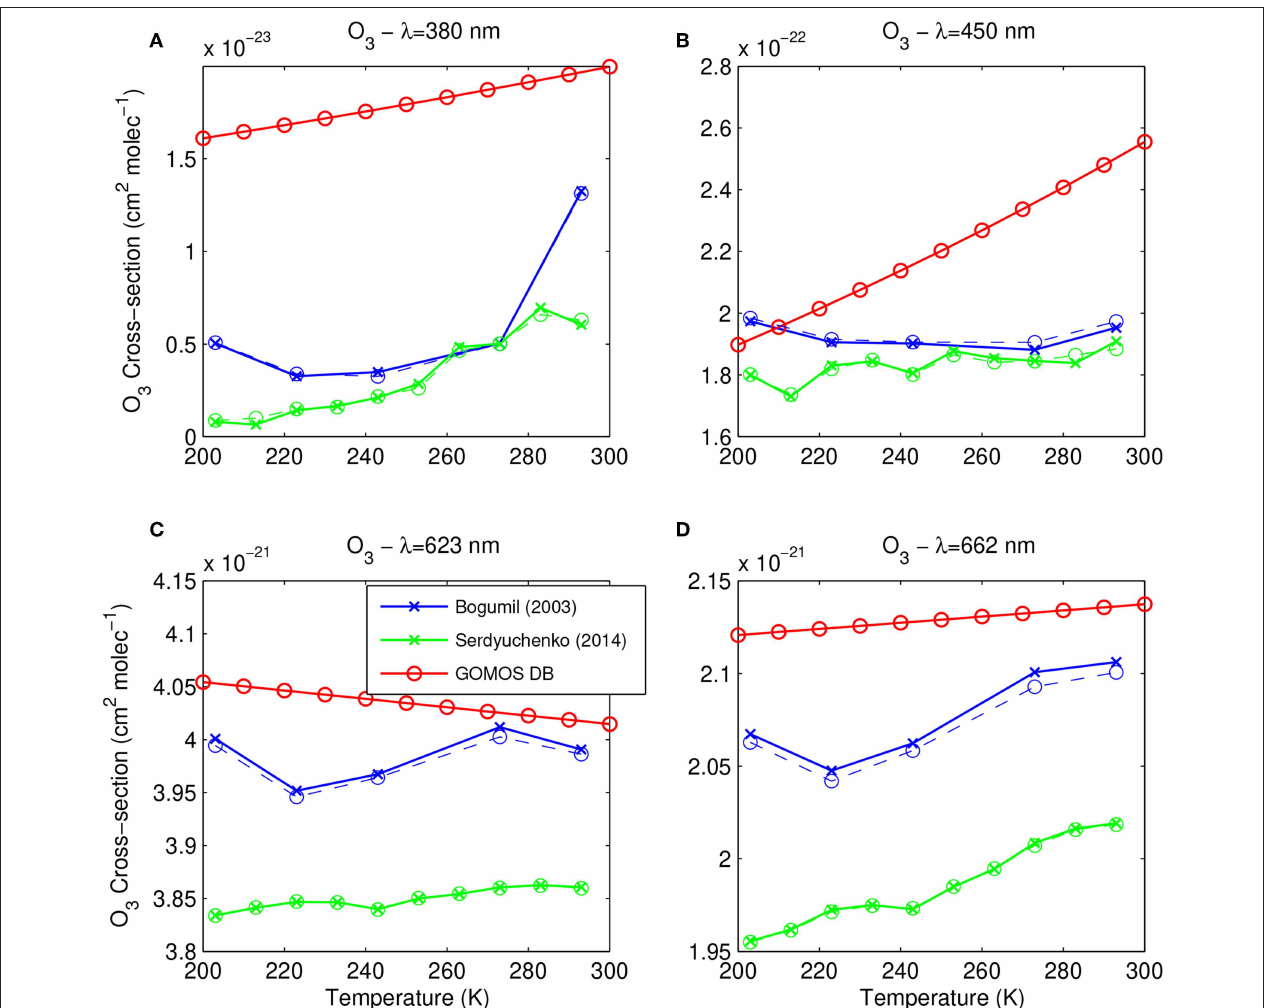
FIGURE 2 | Temperature dependence of the O 3 spectra from Bogumil03 (blue), Serdyuchenko14 (green), and GOMOS DB (red) at (A) λ = 380 nm, (B) λ = 450 nm, (C) λ = 623 nm, and (D) λ = 662 nm. Corresponding spectra of Bogumil03 and Serdyiuchenko14 at GOMOS resolution are plotted in dashed line. Crosses (high resolution) and circles (low resolution) indicate the values provided in the